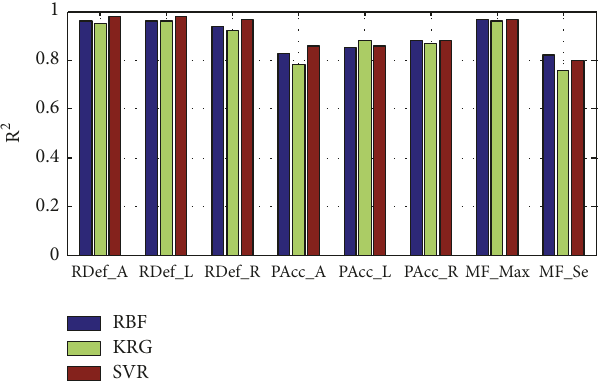
Figure 10: Error comparison of the three different surrogate